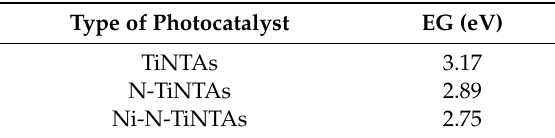
Figure 5. UV-DRS reflectance spectrum of the photocatalysts: ( a ) absorption behavior; ( b ) Tauc plot of the Kubelka–Munk function. Table 2. Bandgap Energy of